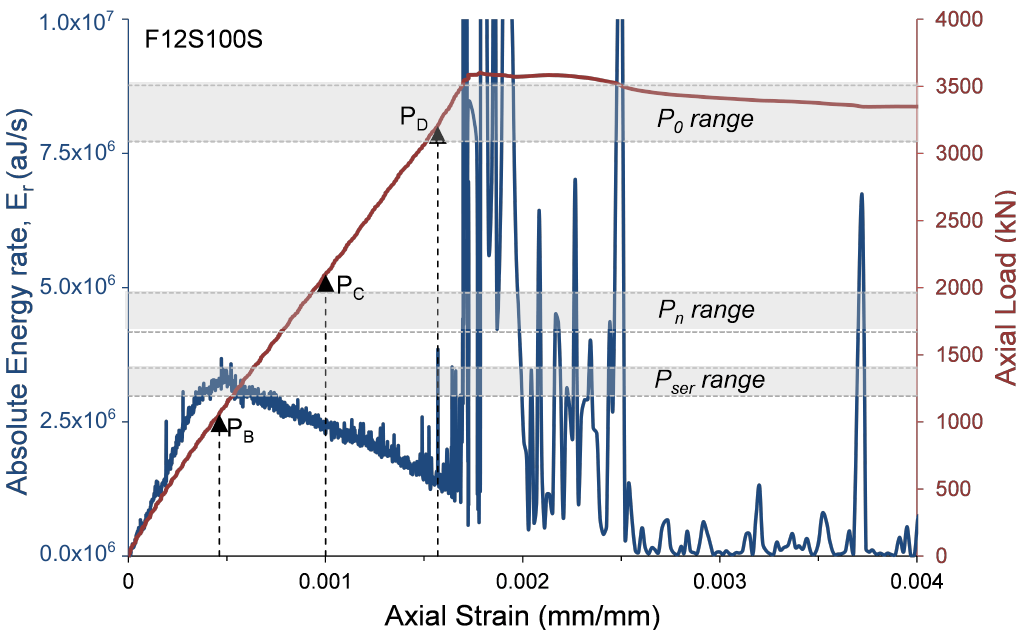
Figure 11. Absolute energy and axial load versus axial strain—specimen F12S100S.